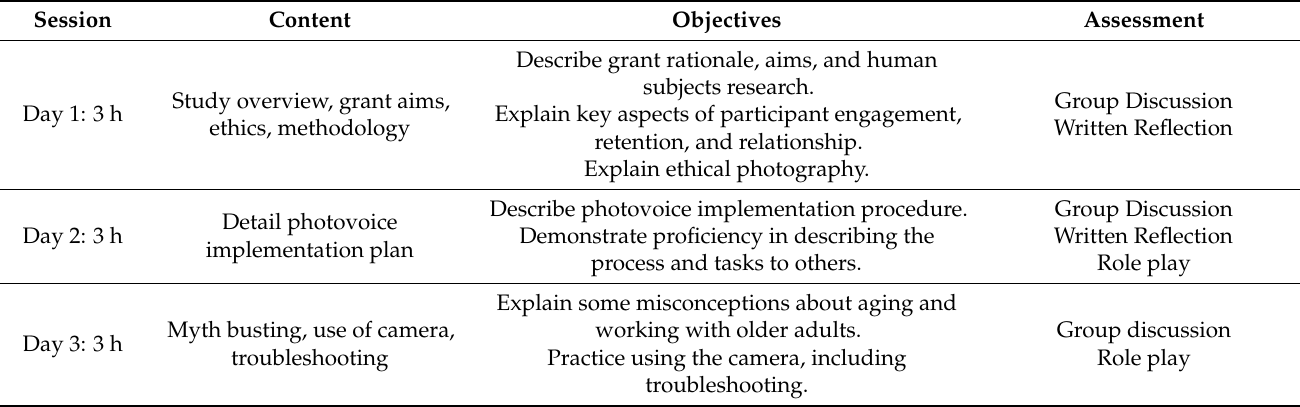
Table 2. Details of the training sessions with research